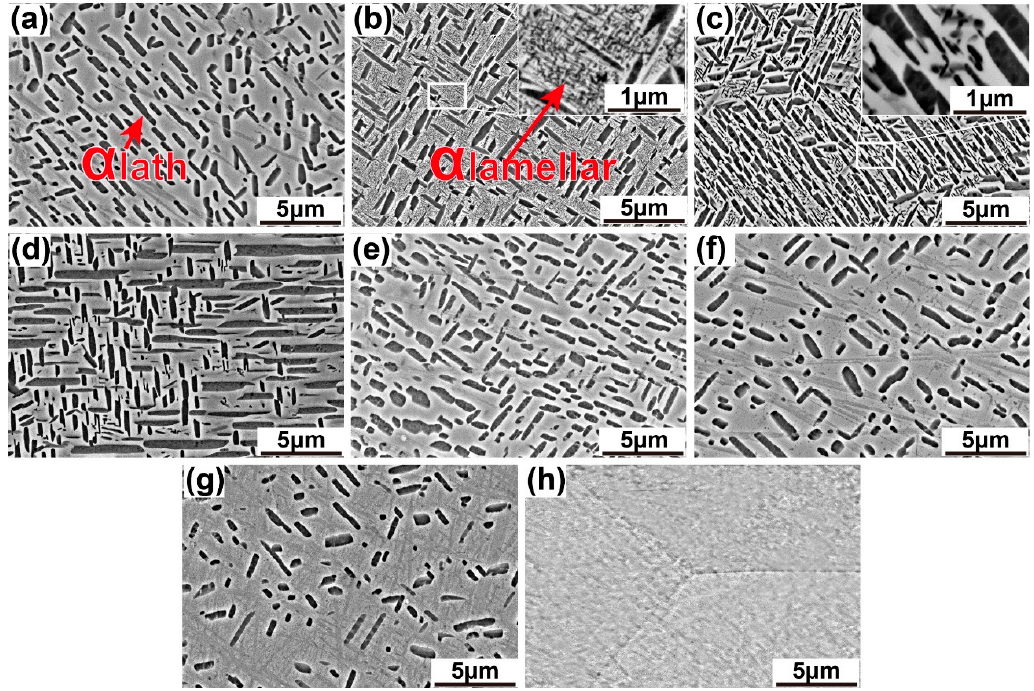
Figure 3. SEM images of the microstructure at ( a ) 410, ( b ) 550, ( c ) 660, ( d ) 700, ( e ) 740, ( f ) 780, ( g ) 800, and ( h ) 840 °C during 1 °C/min heating.